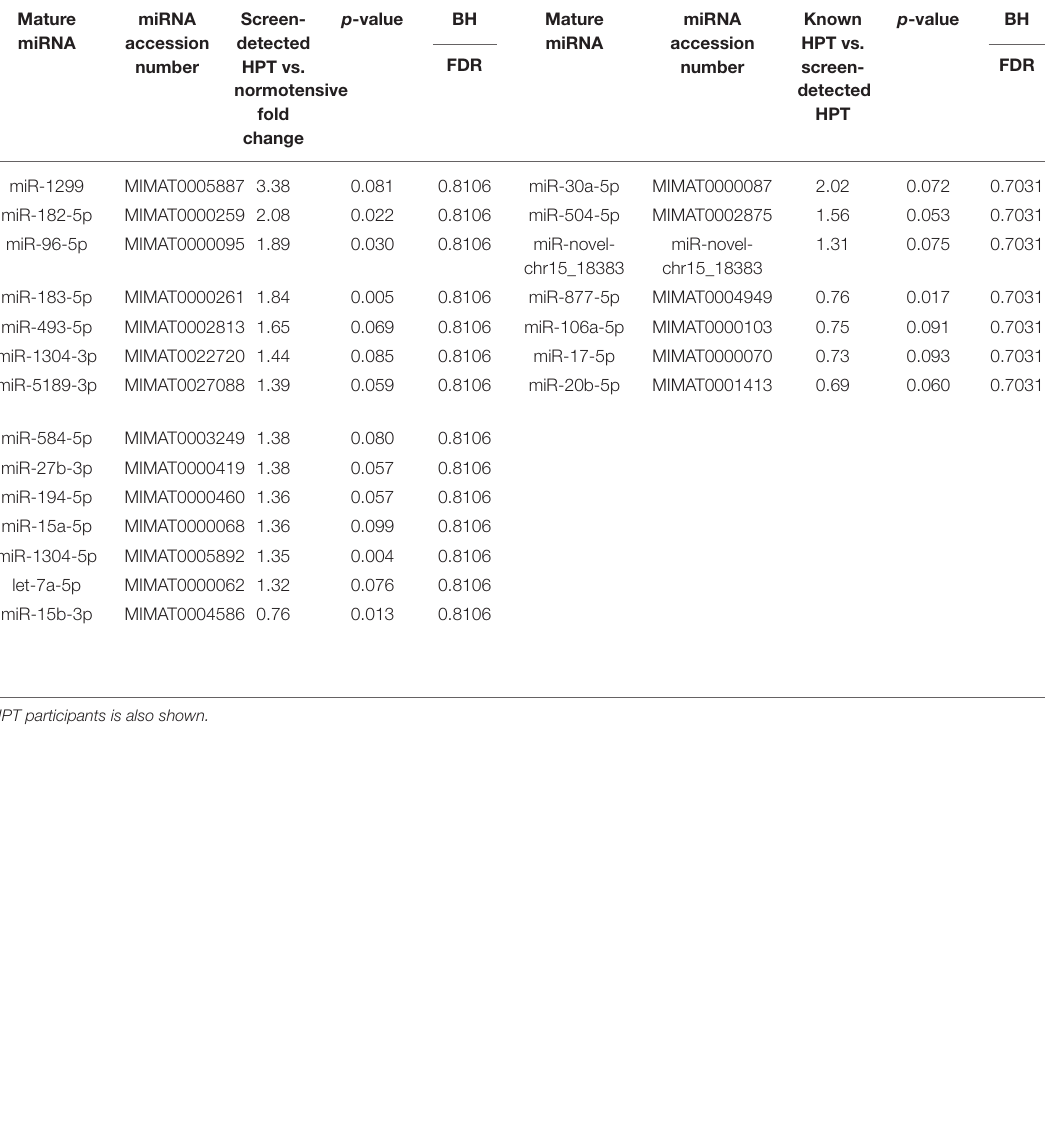
TABLE 2 | Dysregulated mature miRNAs in screen-detected and known HPT compared to normotensive